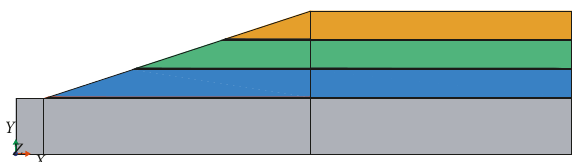
Figure 8: Permeability of MSW layers distributed in the spatial domain.